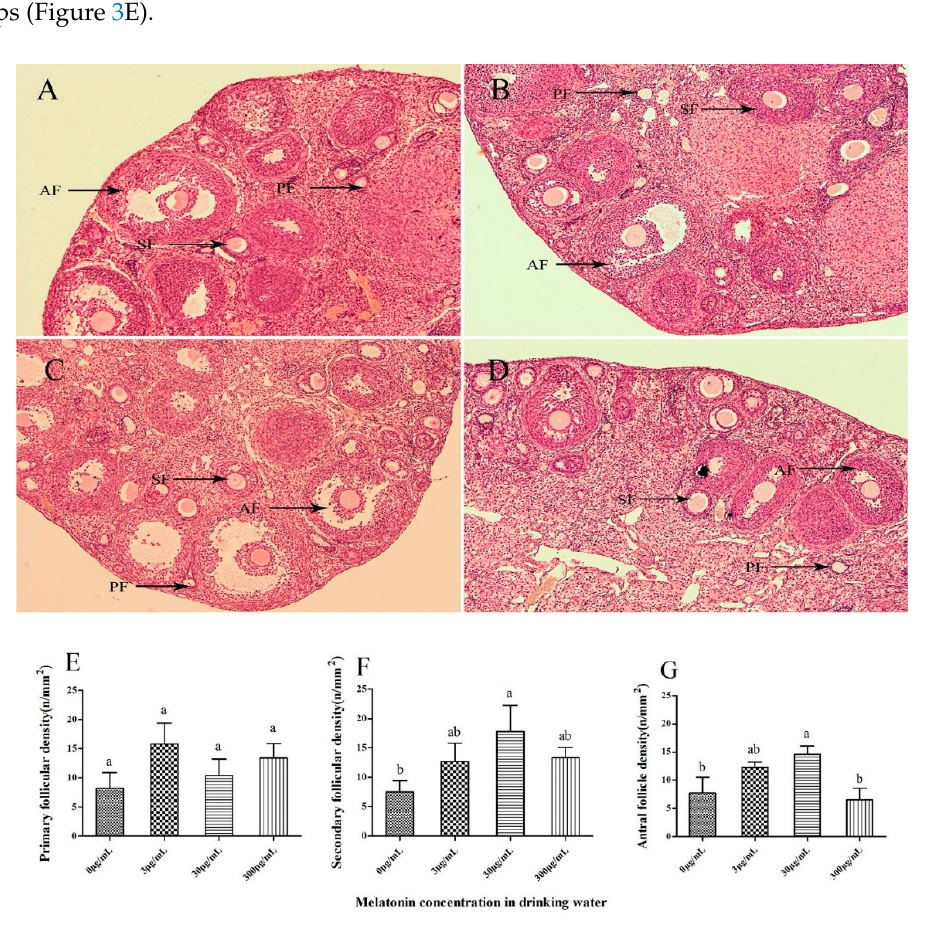
Figure 3. Light microscopy images of mouse ovarian tissues. The tissues displaying a morphologically normal primary follicle (PF) and a secondary follicle (SF) stained with hematoxylin and eosin composed of intact oocytes and well-organized granulosa cells and the antral follicle (AF) were morphologically normal in the control group ( A ), the 3 µ g/mL melatonin-treated group ( B ), the 30 µ g/mL melatonin-treated group ( C ) and the 3 µ g/mL melatonin-treated group ( D ). primary follicular density ( E ), secondary follicular density ( F ) and antral follicular density ( G ) among all groups. Original magnification 100 × . The number of follicles at various developmental stages per unit area (mm 2 ) of the ovarian cortex, follicular density (n/mm 2 ), was counted. Different superscripts (a and b) represent treatment differences within panels ( p < 0.05).